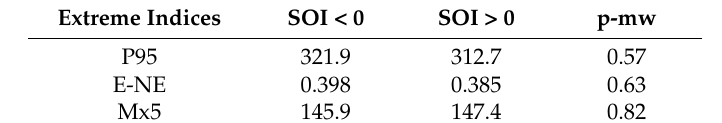
Table 5. Statistical difference tests for the mean in the extreme rainfall indices (P95/mm, E–NE (fraction), MX5/mm) in between class I years with SOI < 0 and class II years with SOI > 0.